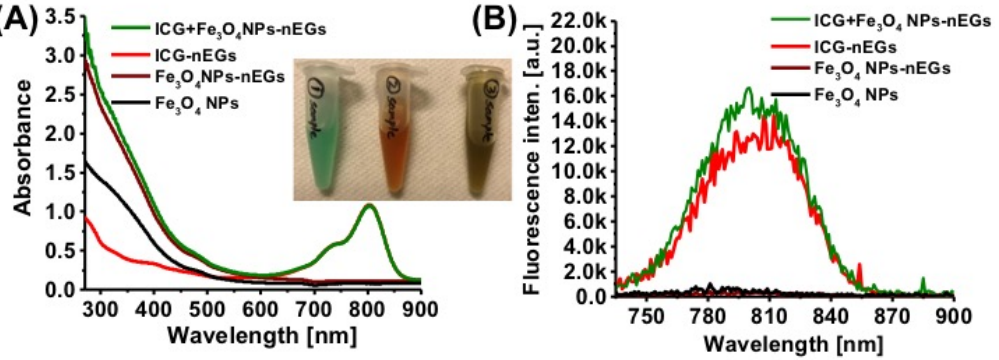
Figure 6. ( A ) Absorption and ( B ) fluorescence emission spectra of nEGs loaded with ICG and Fe 3 O 4 NPs (ICG + Fe 3 O 4 NPs-nEGs). For comparison, spectra for Fe 3 O 4 NPs, ICG-nEGs, and nEGs loaded with Fe 3 O 4 NPs (Fe 3 O 4 NPs-nEGs) are also shown. Diameters of Fe 3 O 4 NPs were in the range of ~5–10 nm. nEGs were formed by extrusion of EGs, and then loaded with ICG and Fe 3 O 4 NPs. Concentrations of ICG and Fe 3 O 4 NPs in the hypotonic loading buffer were 20 µ M and 1 mg/mL, respectively. The inset on panel ( A ) shows, from left to right, photographs of ICG-nEGs, Fe 3 O 4 NPs-nEGs, and ICG + Fe 3 O 4 NPs-nEGs suspended in isotonic PBS. Absorption > 600 nm is due to ICG. Fluorescence emission was recorded in response to photoexcitation at 720 nm. Presence of Fe 3 O 4 NPs in ICG + Fe 3 O 4 NPs-nEGs had minimal effect on absorption and fluorescence emission characteristics of the particles as compared to those for